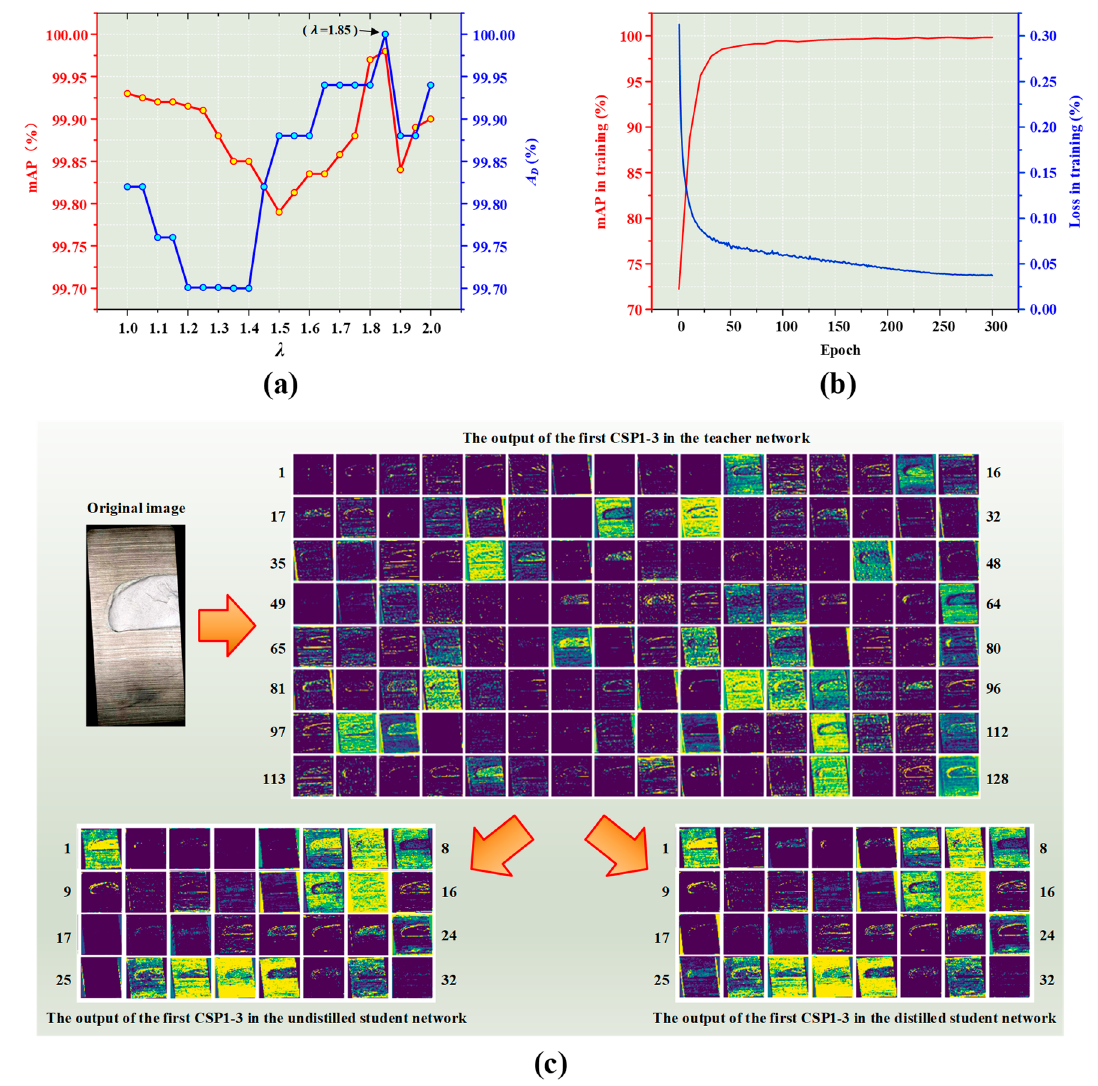
Figure 7. Results of the knowledge distillation for the student network: ( a ) the contribution of the introduced weight factor 𝜆 to the accuracy improvement; ( b ) the mAP and loss of student network during the training process; ( c ) the output visualization of the specific layer in the networks before and after knowledge distillation.